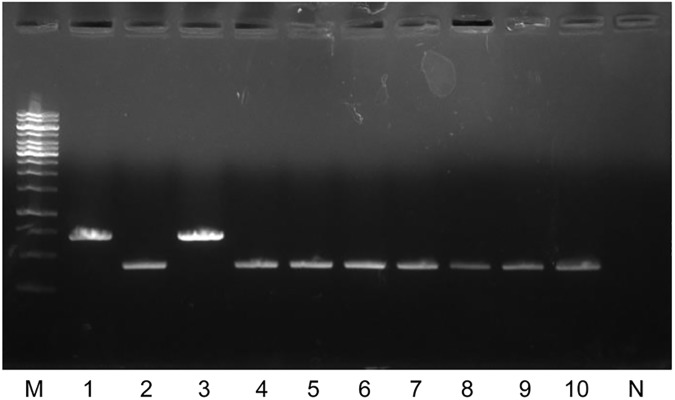
The identification of 6 Rec-mas strains into subspecies levels by PCR targeting the erm(41) gene.M, 1 kb DNA ladder; Lane 1, M. abscessus CIP 104536T; Lane 2, M. massiliense CIP 108297T; Lane 3, M. bolletii CIP 108541T; Lane 4, Asan 50594 (Type II); Lane 5, Asan 50375 (Type I, Seq2); Lane 6, Asan 52748 (Type I, Seq1); Lane 7, Asan 53996 (Type I, Seq1); Lane 8, Asan 54142 (Type I, Seq1); Lane 9, Asan 56120 (Type I, Seq1); Lane 10, Asan 61912 (Type I, Seq1); N, negative control.